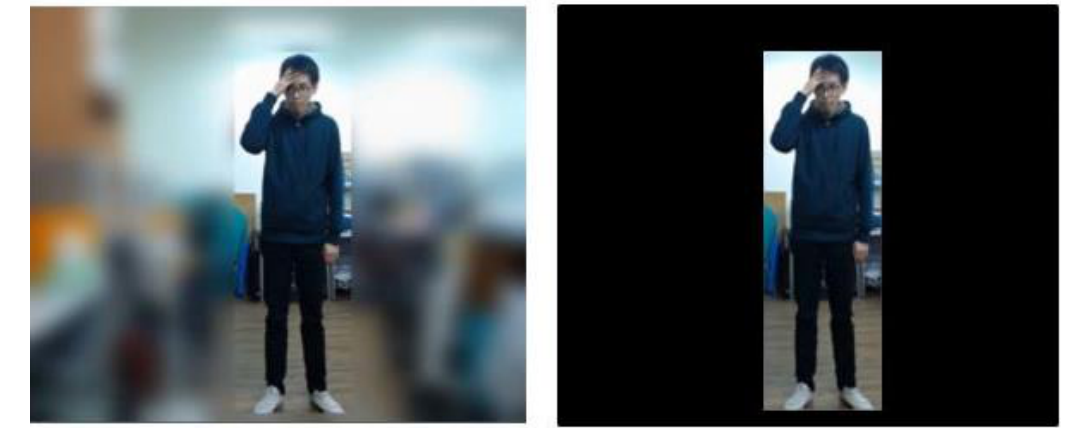
Figure 13. Images with blurred background ( left ) and black background ( right ).